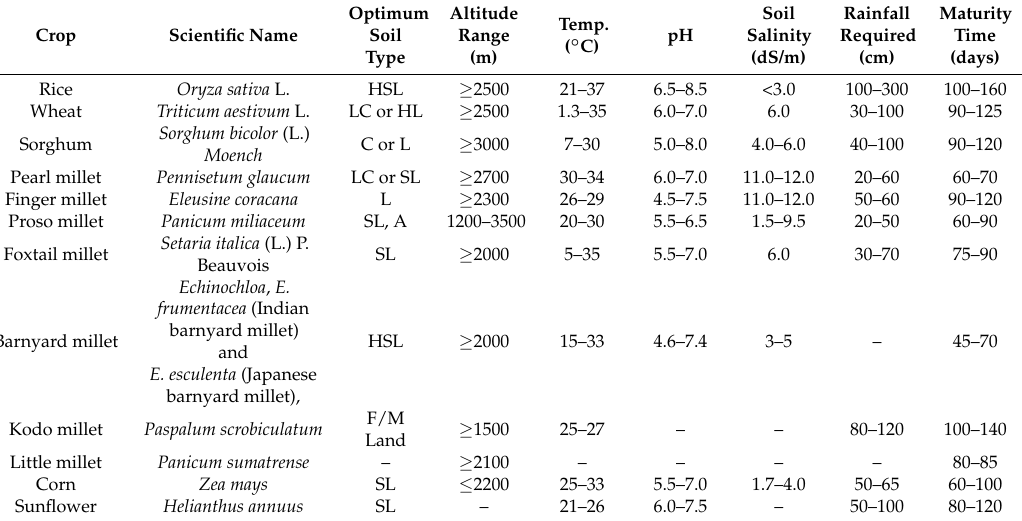
Table 1. Optimal environmental conditions for the major cereal crops and